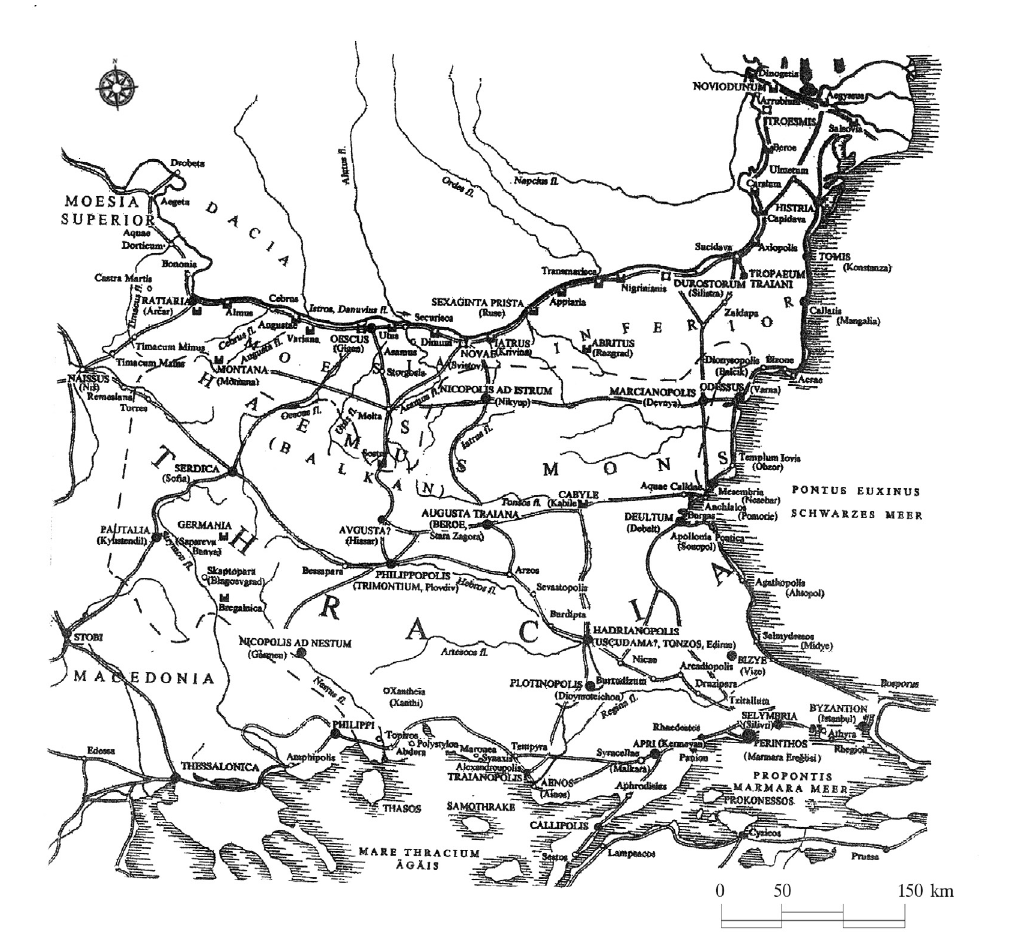
Figure 1. The Roman province of Thrace (after Ivanov, 2012,